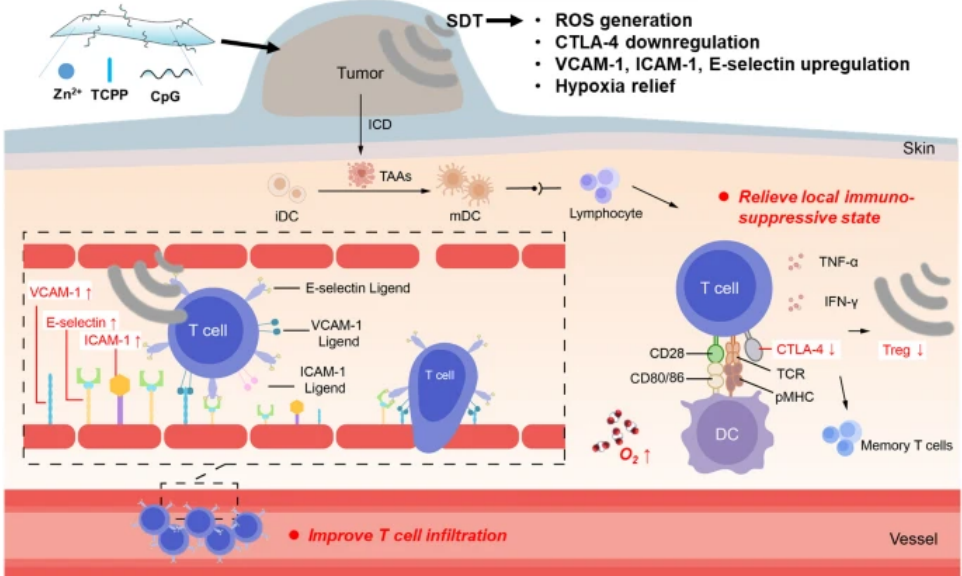
Figure 7. Schematic image of the synthesis of Zn-TCPP/CpG nanosheets and the mechanism of immune responses induced by Zn-TCPP/CpG-based SDT. Briefly, The SDT with Zn-TCPP/CpG could induce ICD of cancer cells and release TAAs, which could be engulfed and presented by DCs with the assistance of CpG. The immune system could be activated to suppress tumor metastasis owing to the antigen presentation by matured DCs. Moreover, ultrasound itself could strengthen anti-tumor immune responses by improving the tumor infiltration of T cells and limiting regulatory T cells in the tumor microenvironment. Reprinted with permission from Ref. [174]. 2020, Springer Nature.